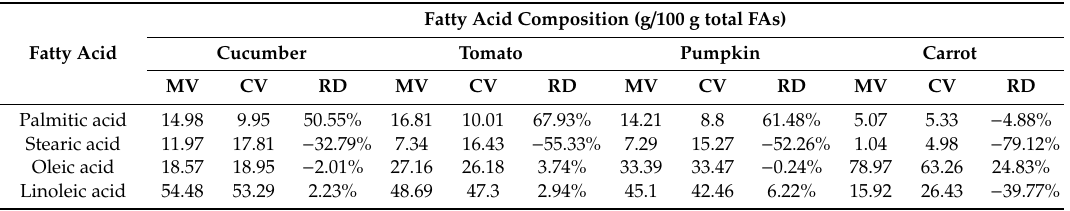
Table 3. Comparison of relative concentration of fatty acid compositions determined by GC